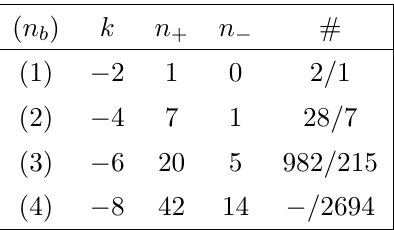
Table 1 . The weight k , the indices n ± , and the number of terms # in the numerator φ k,n of the partition function of the massive/massless